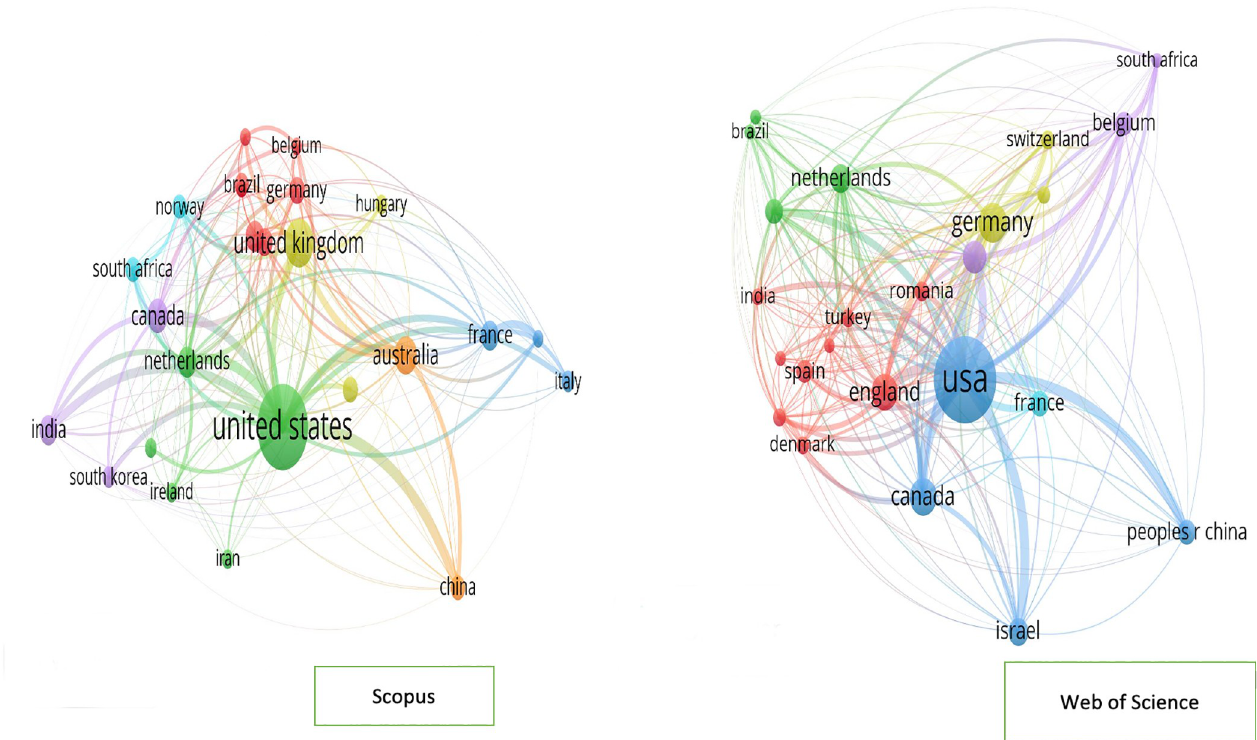
Fig 3. Bibliometric analysis. Note: Analysing studies of sadness regulation by countries in the Web of Science and Scopus databases. This figure indicates the collaborations in studies related to sadness regulation among the US, China, Canada, Israel, and the UK.